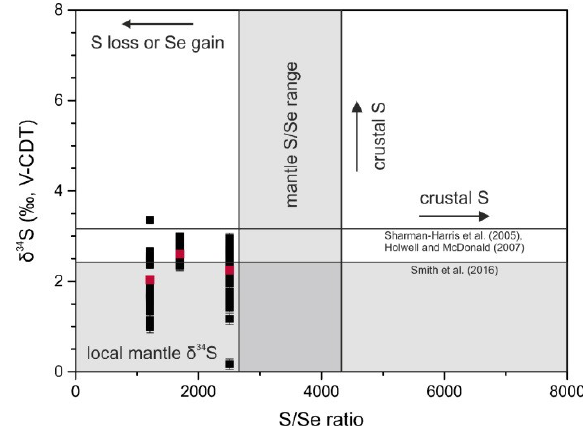
Figure 13. δ 34 S and bulk rock S/Se systematics of sample OY541-1, OY541-3b and OY541-4a. Red squares represent median values of the samples. Horizontal lines represent different suggested δ 34 S ranges for a pristine Bushveld magma.